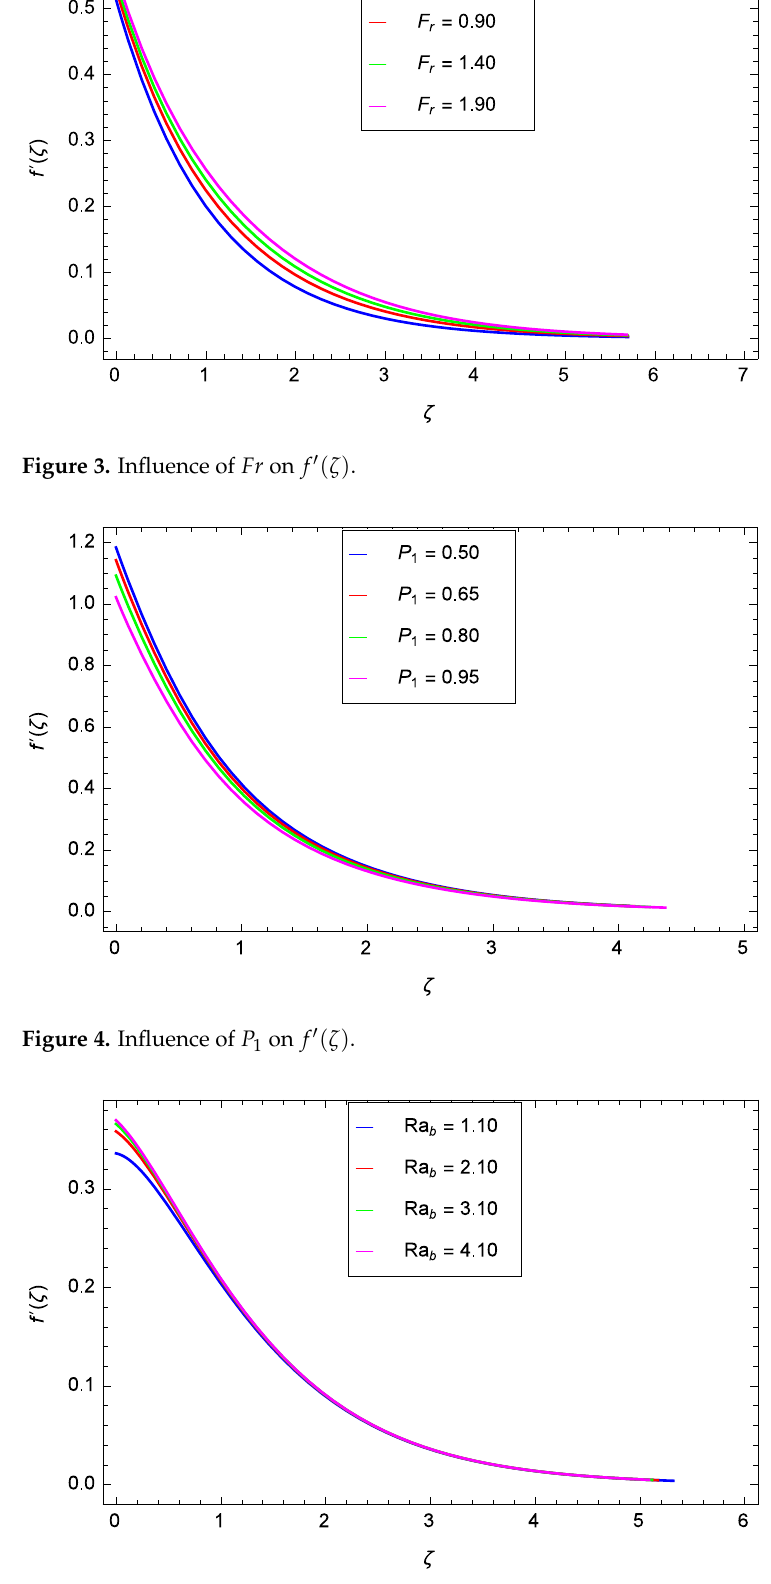
Figure 5. Influence of Ra b on f (cid:48) ( ζ )